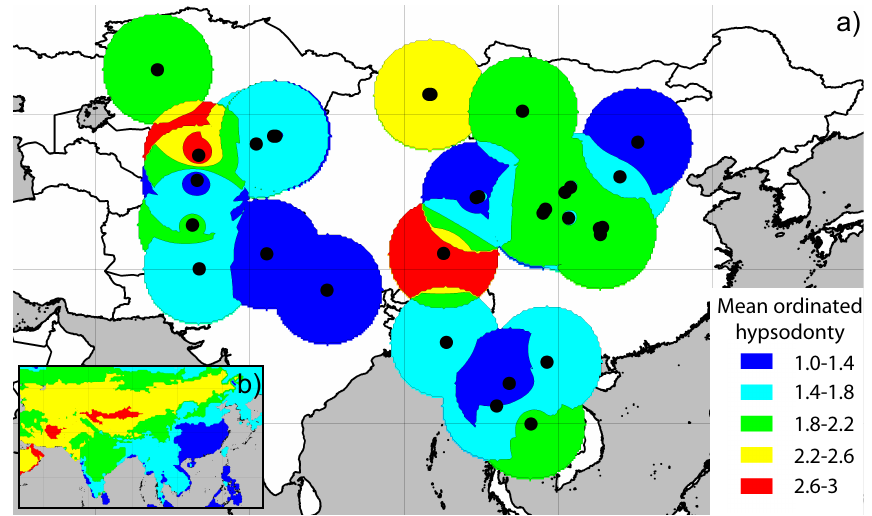
Fig. 10. The colour-interpolated map of large mammal plant-eater mean hypsodonty by fossil localities (black dots) in Asia during the early Late Miocene (11–8Ma ) (Eronen et al., 2010b) (a) compared with the present day (Eronen et al., 2010a) (b) . The higher hypsodonty indicates lower precipitation, and vice versa.